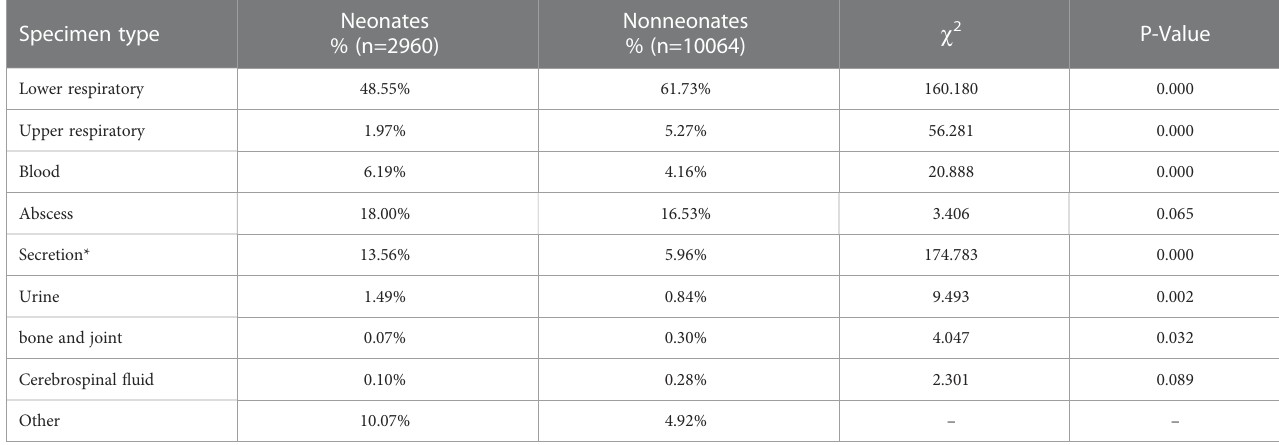
TABLE 1 Distributions of MRSA in neonates and nonneonates in 2016 to 2021.